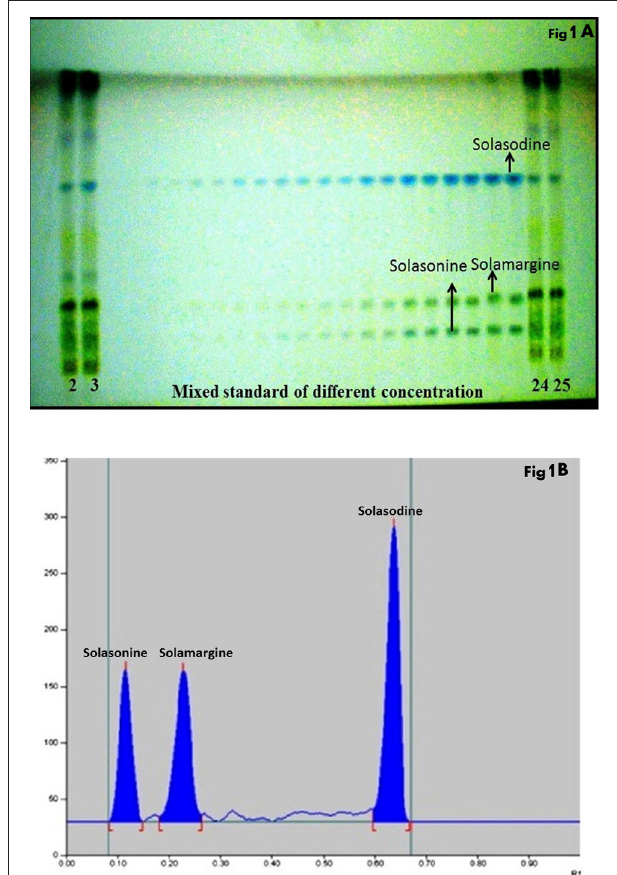
FIGURE 1 | (A) Developed HPTLC plate visualized at normal light after derivatisation. (B) HPTLC chromatogram of standards solasonine ( R f 0.11 ± 0.02), solamargine ( R f 0.22 ± 0.02) and solasodine ( R f 0.63 ± 0.02) scanned at 530